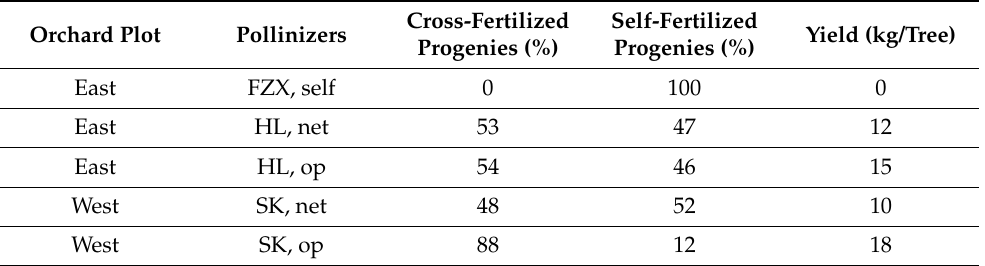
Table 4. Fertilization rate and final yields of FZX by different pollinizers (OP = open pollination). Cross-Fertilized Self-Fertilized Orchard Plot Pollinizers Yield (kg/Tree) Progenies (%) Progenies (%) East FZX, self 0 100 0 East HL, net 53